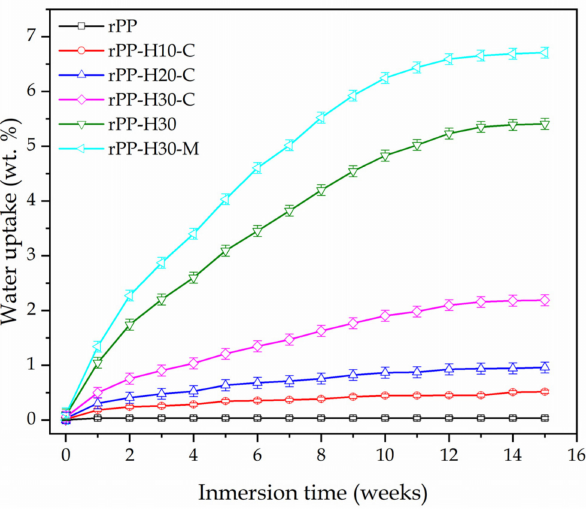
Figure 6. Comparative plots of the evolution of the water uptake as a function of the immersion time of rPP pieces and the rPP/hemp fiber composites with different compatibilizers.